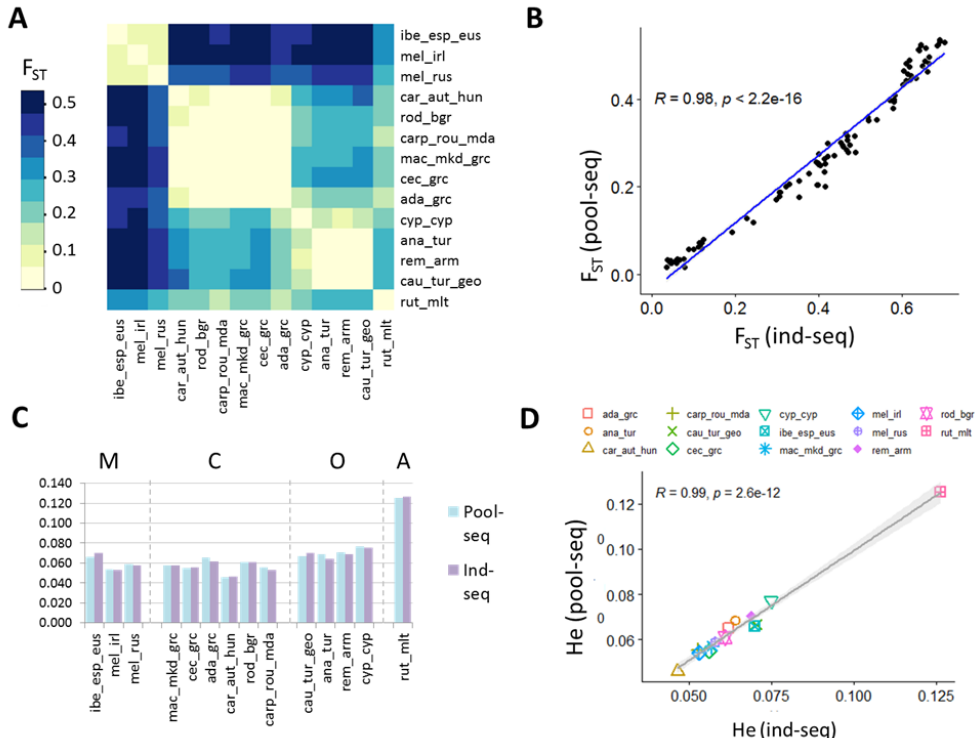
Figure 3. Genetic variation between and within populations. ( A ) Heatmap based on whole-genome pairwise average FST between each population pair calculated from pool-seq data. ( B ) Correlation of pairwise FST estimates between pool-seq and ind-seq data. ( C ) Expected heterozygosity for each population as estimated by pool and ind-seq. ( D ) Correlation between heterozygosities as estimated by pool-seq and ind-seq data. M-lineage: ibe_esp_eus = A. m. iberiensis from